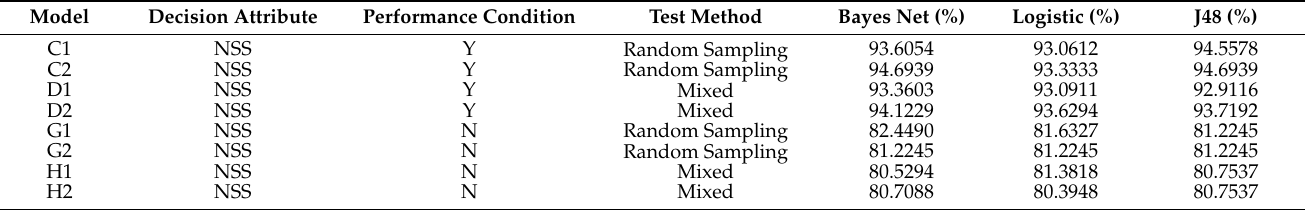
Table 9. Statistical table with NSS as decision